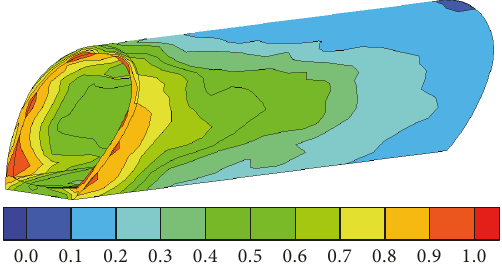
Figure 11: Damage coefficients’ distribution of lining after the